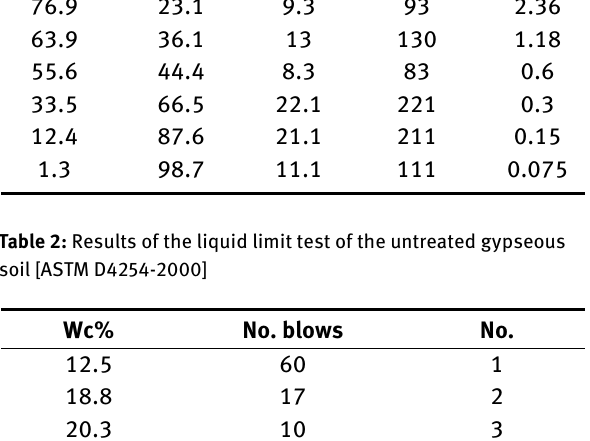
Figure 1: Flowchart of the research